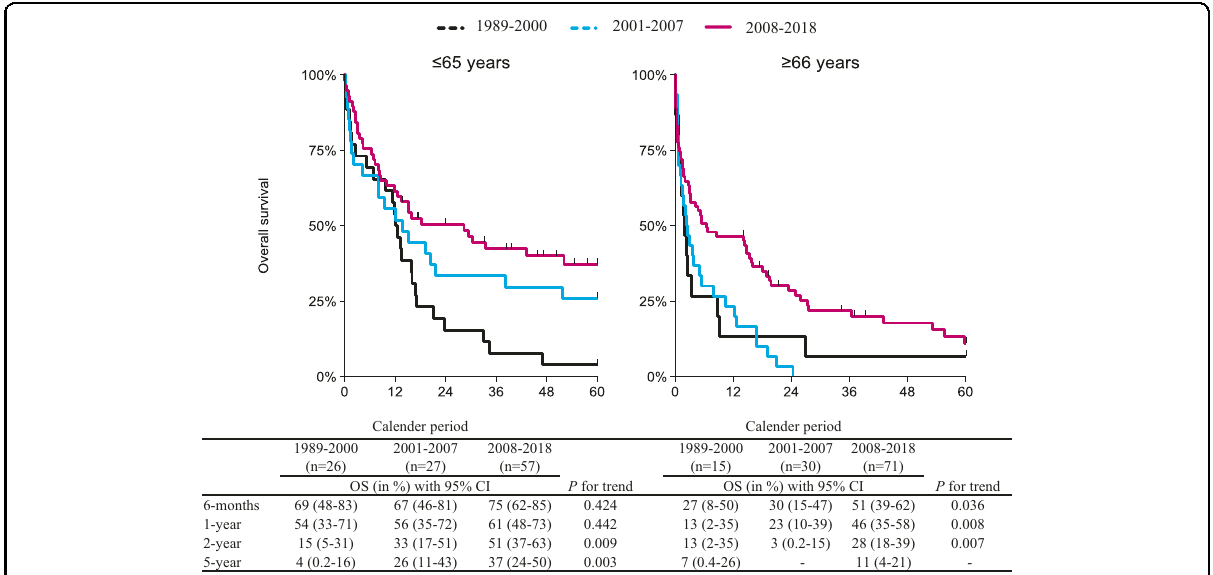
Fig. 2 Overall survival (OS) of patients with pPCL in the Netherlands, 1989 – 2018. OS is strati fi ed by calendar period of diagnosis and shown for the following age categories: ≤ 65 years (left panel), and ≥ 66 years (right panel). The P -value of the log-rank test for trend is indicated in the